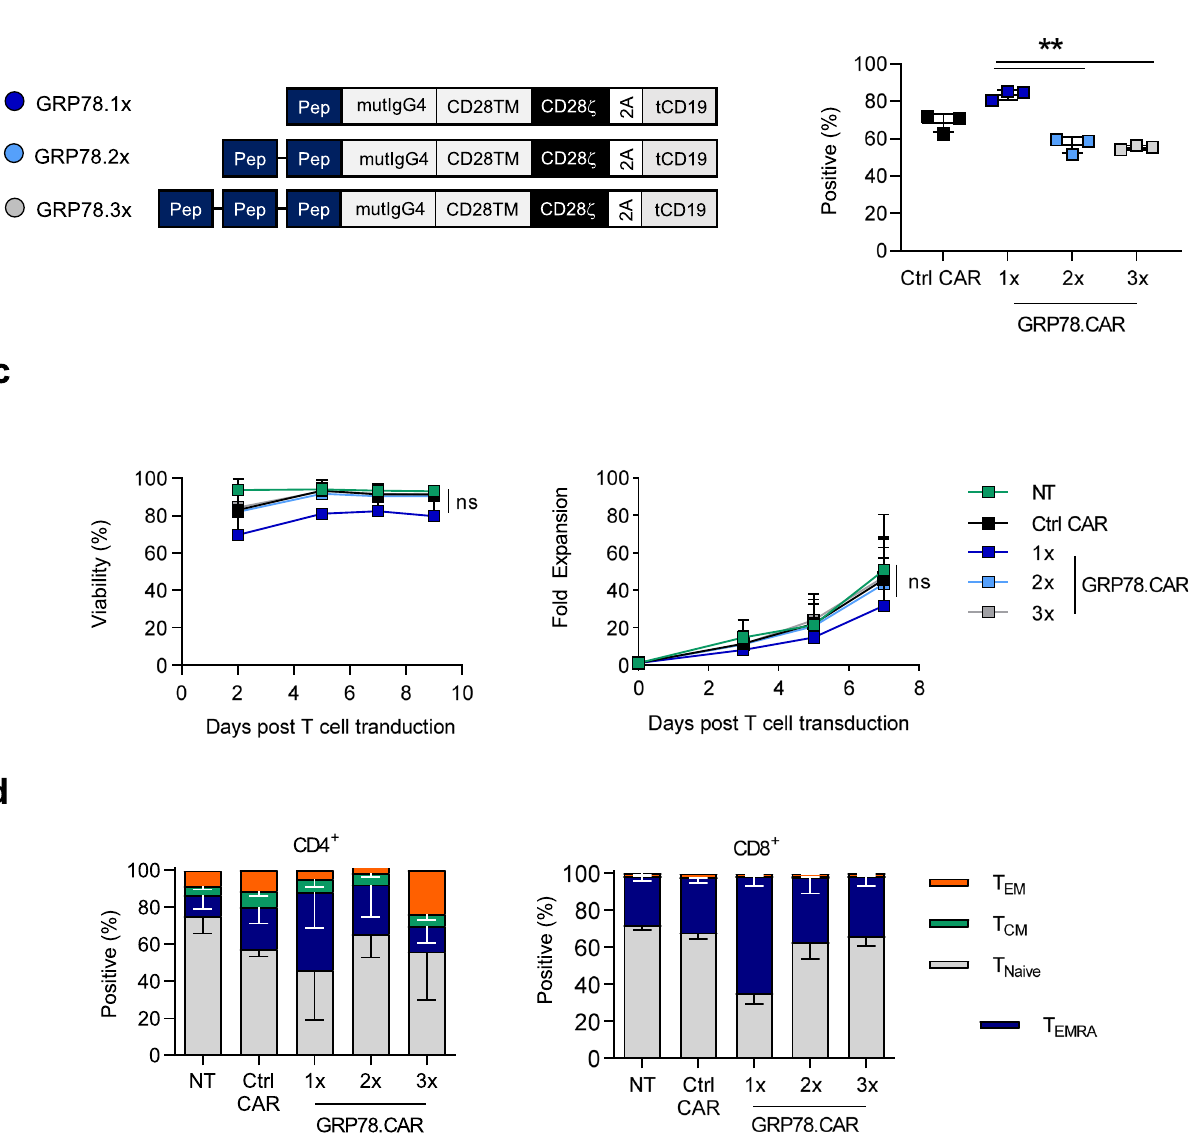
Fig. 2 Generation and characterization of GRP78-CAR T cells. a Scheme of retroviral vectors encoding GRP78.1x-, GRP78.2x-, and GRP78.3x-CARs ( ‘ Pep ’ stands for peptide). b Transduction ef fi ciency of GRP78-CAR constructs probing for tCD19 using fl ow cytometry on days 5 – 7 after retroviral transduction (control CAR: FRP5-CAR) ( N = 3, 1x vs 2x p = 0.0008, 1x vs 3x p < 0.0001, 2x vs 3x p = 0.6131, two-sided T -test for pairwise comparisons was used). c Cell viability of CAR T cells measured from day 2 to day 9 post transduction using trypan blue (left panel, N = 3, p = ns, two-sided T -test for pairwise comparisons was used). Expansion of NT, Control CAR or GRP78 peptide CAR T cells measured for 7 days after transduction (right panel, N = 3, p = ns, two-sided T -test for pairwise comparisons was used). d Flow cytometric analysis of immunophenotype of GRP78 CAR transduced cells on day 7 post transduction (EM: CCR7 − , CD45RA − ; CM: CCR7 + , CD45RA − ; Naive-like: CCR7 + CD45RA + ; T EMRA : CCR7-, CD45RA + ) ( N = 3, T -test was used with pairwise comparisons, p < 0.05). The data in Fig. 2 are presented as mean values ± SD. Source data are provided as a Source data fi